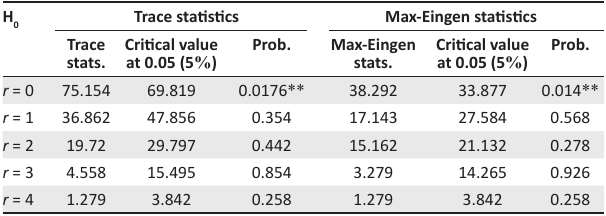
TABLE 3: Johansen co-integration